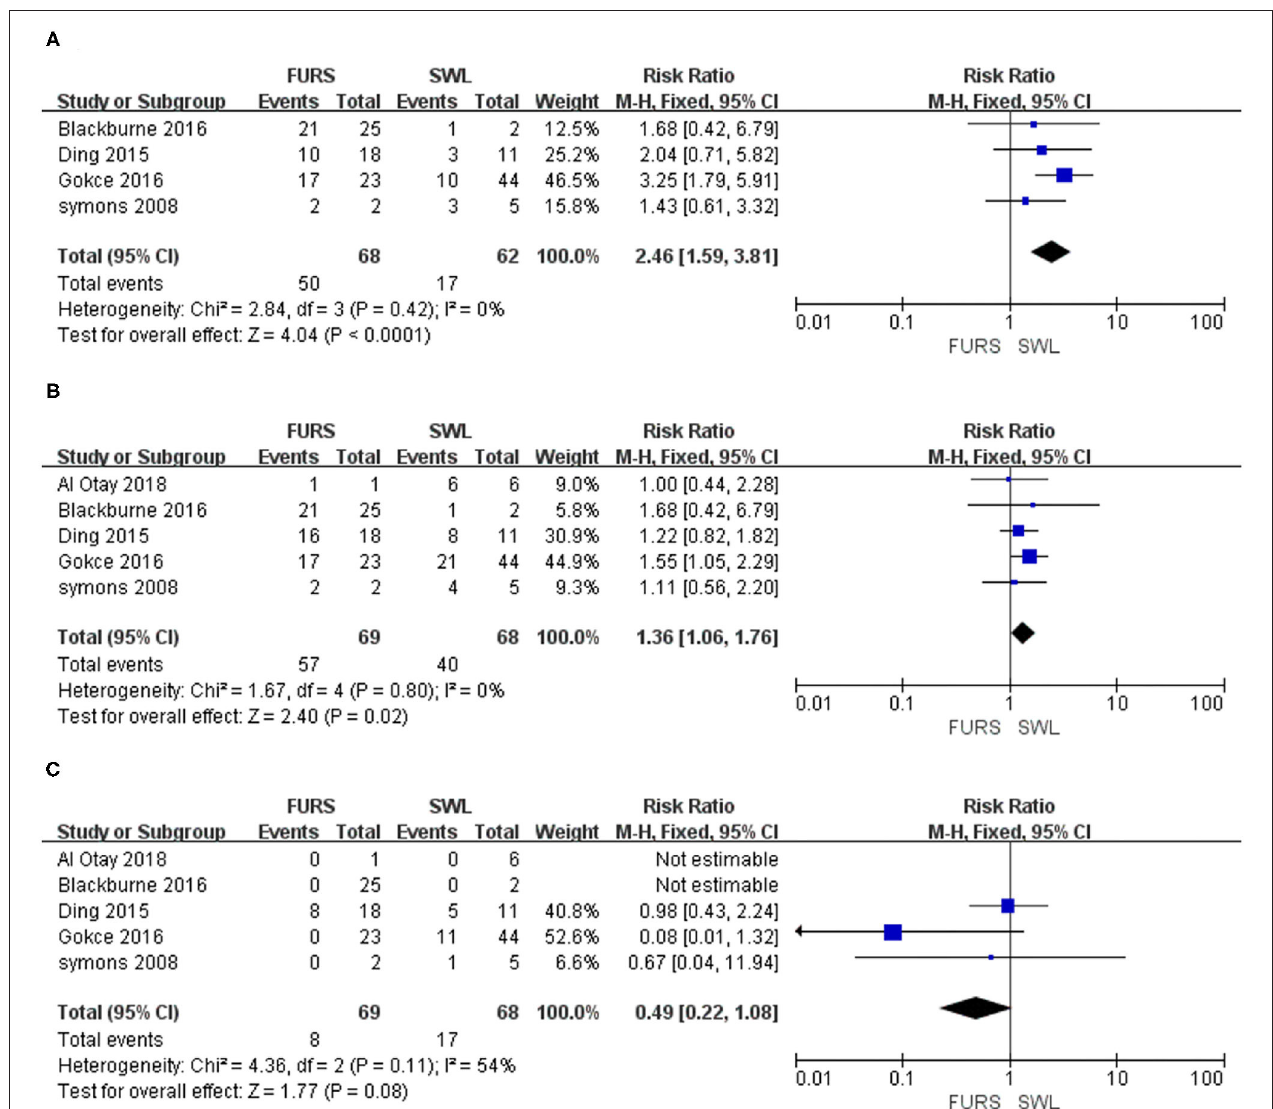
FIGURE 2 | (A) Forest plot of initial stone-free rates for SWL vs. FURS. (B) Forest plot of overall stone-free rates for SWL vs. FURS. (C) Forest plot of retreatment ratios for SWL vs. FURS. SWL, extracorporeal shock wave lithotripsy; FURS, flexible ureteroscopy; CI, confidence interval; M–H,